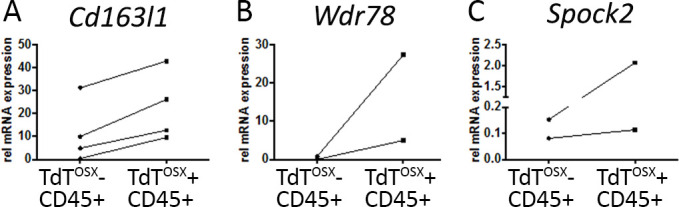
Validation of RNAseq data.Real Time PCR performed on TdTOSX+;CD45+ and TdTOSX+;CD45- populations sorted from B16-F10 tumors in doxy-fed mice. Each sample is a pool of two tumors. Data show three genes (A) Cd163l1, (B) Wdr79 and (C) Spock2 to be upregulated in the TdTOSX+;CD45+ compared to TdTOSX-;CD45+ cells.Figure 5—figure supplement 1—source data 1.Relates to Real-Time PCR data.